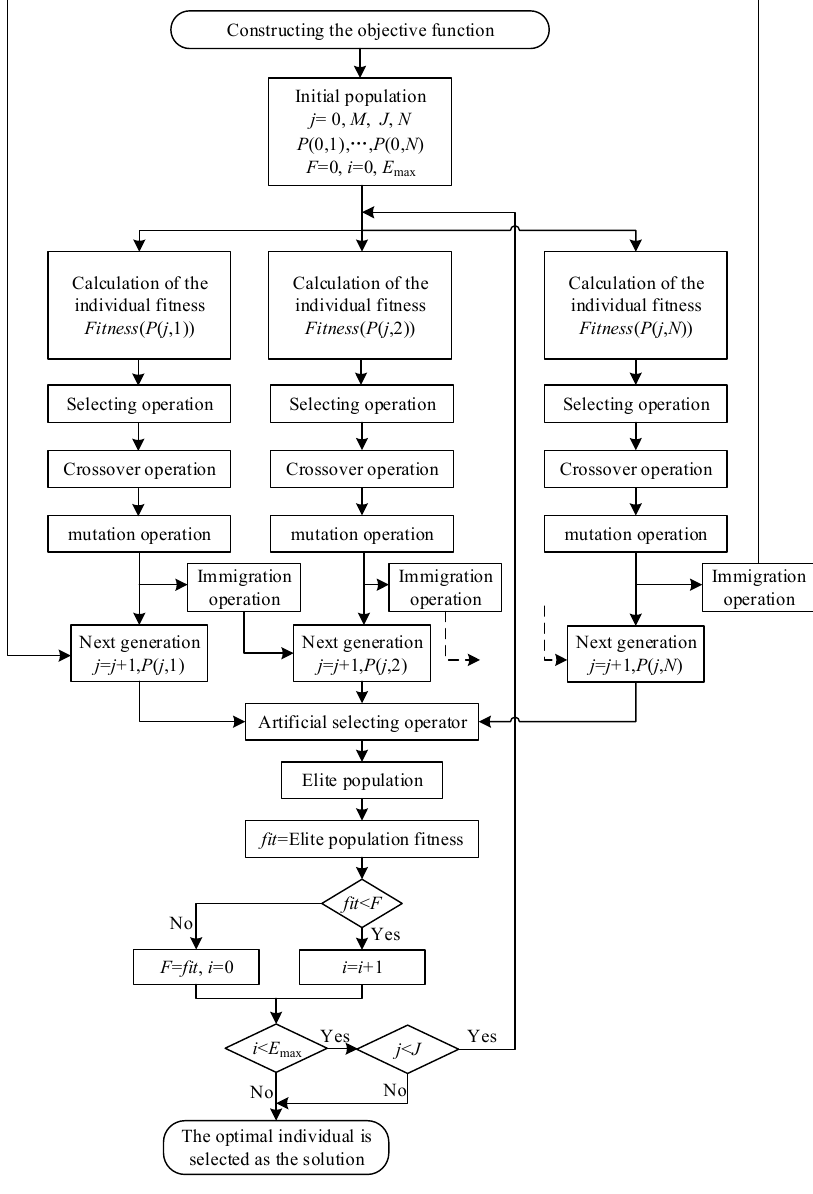
Figure 20. Schematic diagram of MPGA.